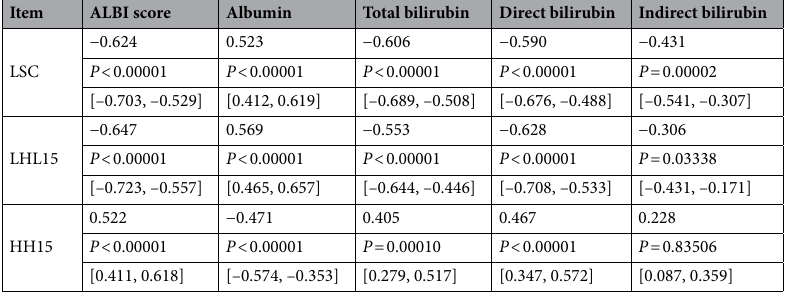
Table 2. Correlation coefficients of the liver–spleen contrast (LSC), receptor index (LHL15), and blood clearance index (HH15) with the albumin-bilirubin (ALBI) scores and laboratory parameters. P statistical significance. The 95% confidence interval is presented as numbers in square